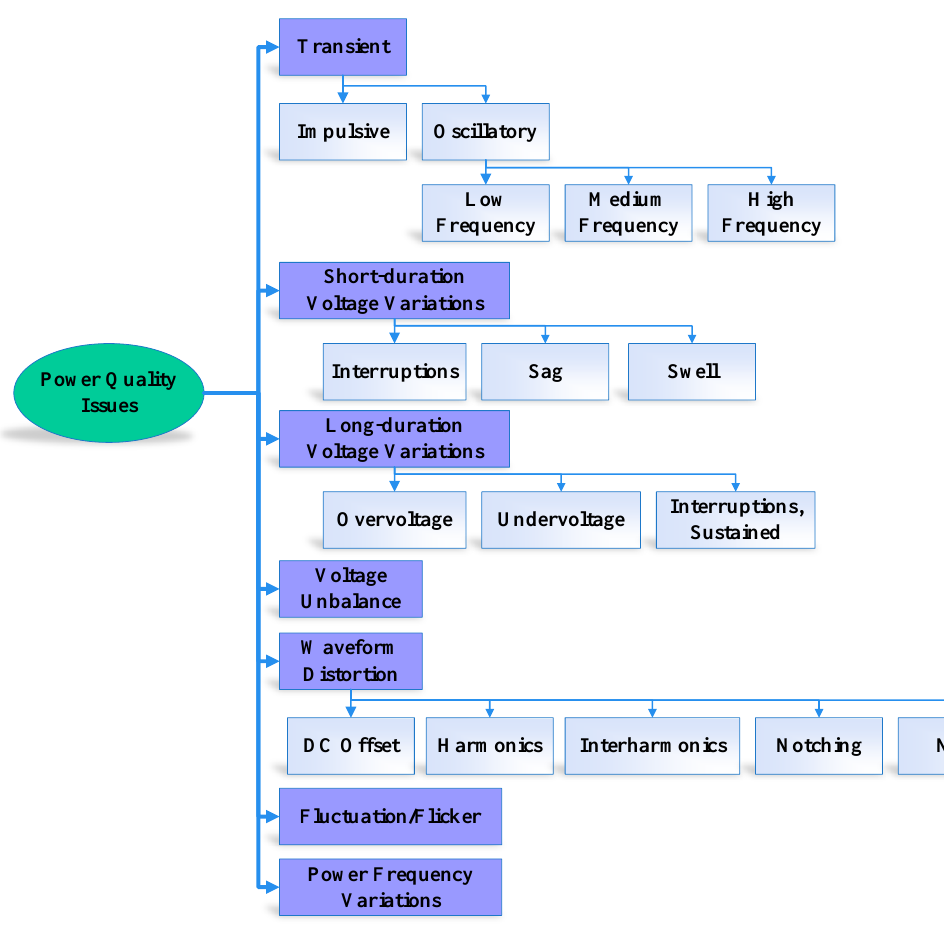
Figure 2. Classification of power quality issues. Based on data from [20]. Table 2. Power quality issues and their definitions, causes, and e ff ects. Based on data from [20–29]. Table 1. All standards associated with power quality issues. Based on data from [20 – 29]. Power Quality